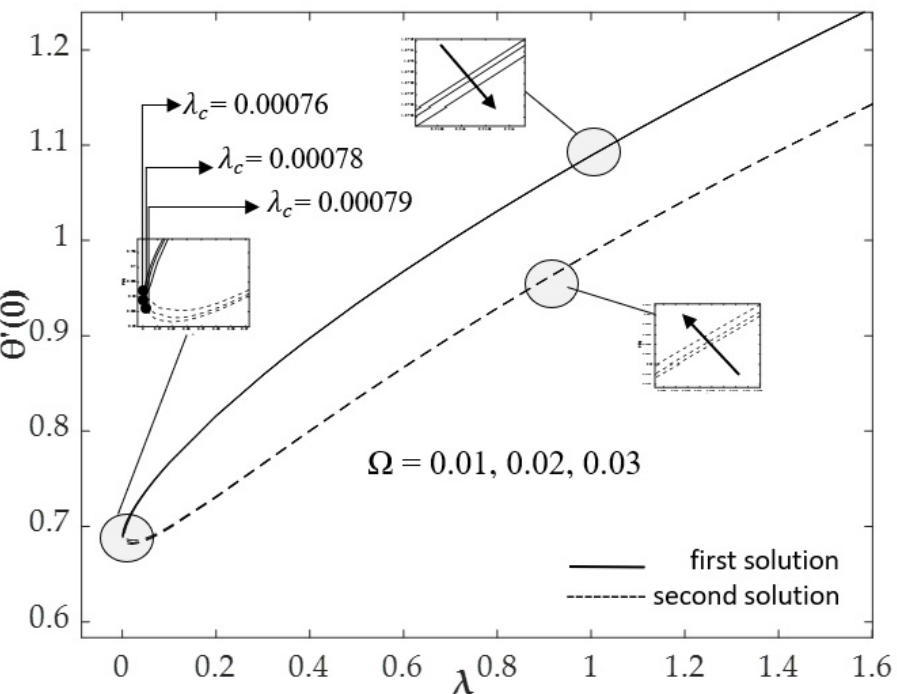
( ) 0 θ′− with stretching parameter λ for different